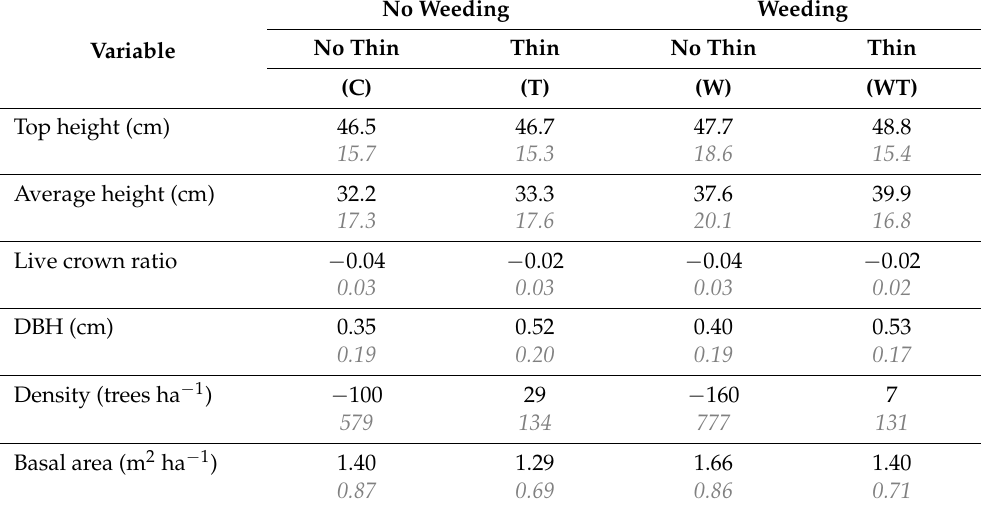
Table 3. Periodic annual increments between 15 and 17 growing seasons after planting: means and standard